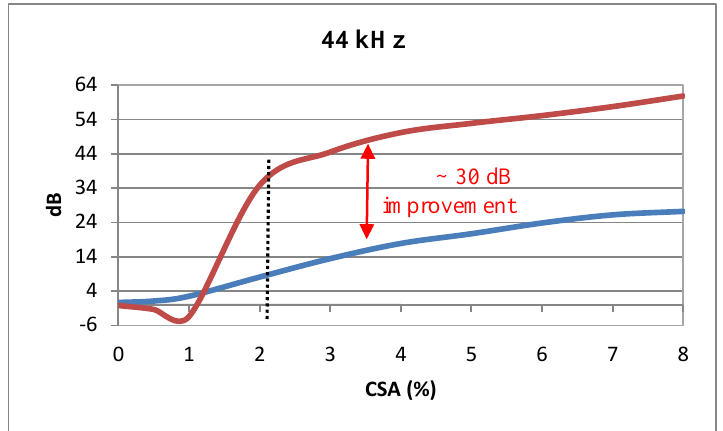
Figure 9. SNR calculation – peak amplitude of the defect (S) to the root mean square (RMS) value of the noise region (N) for 44 kHz.